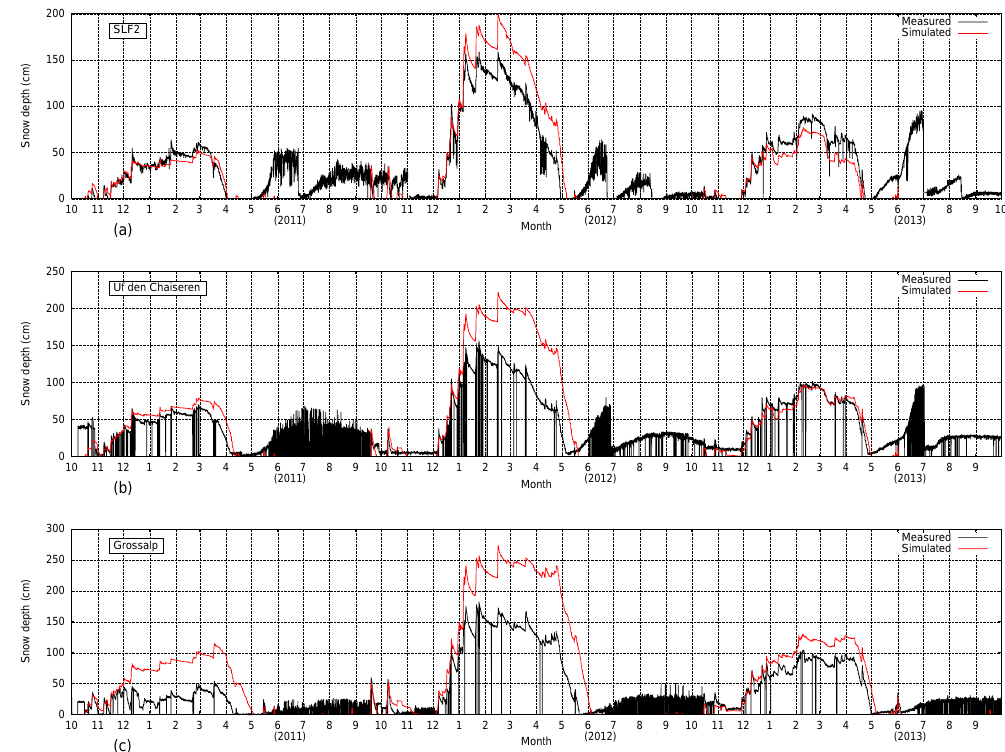
Figure 4. Measured and simulated snow depth for stations SLF2 (a) , Uf den Chaiseren (b) and Grossalp (c) for the period October 2010 to October 2013. Noisy signals in the summer months arise from grass growth below the sensor.